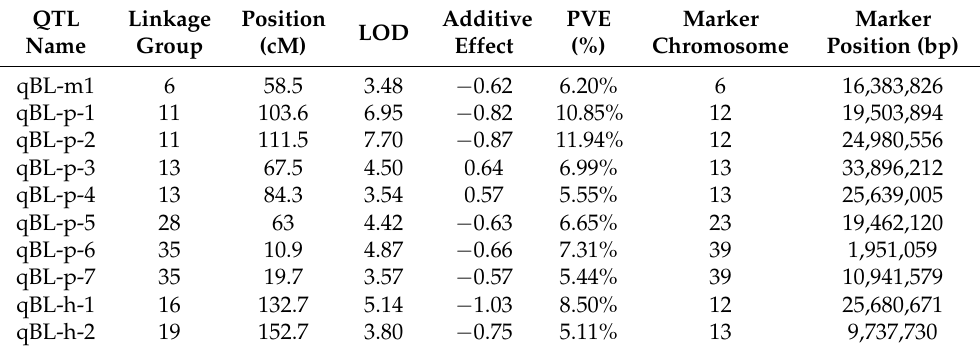
Table 2. Body length-associated QTL identified in Yellow River carp 5–17 months after